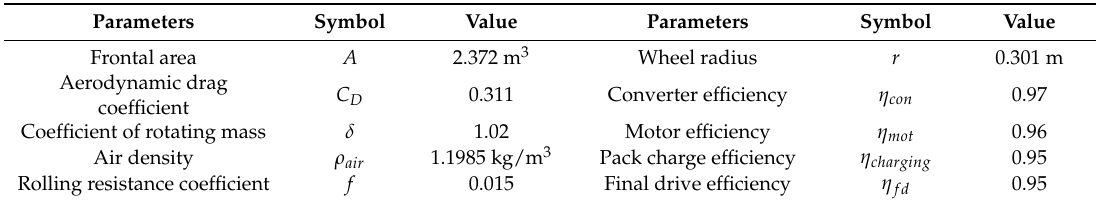
Table 3. Vehicle